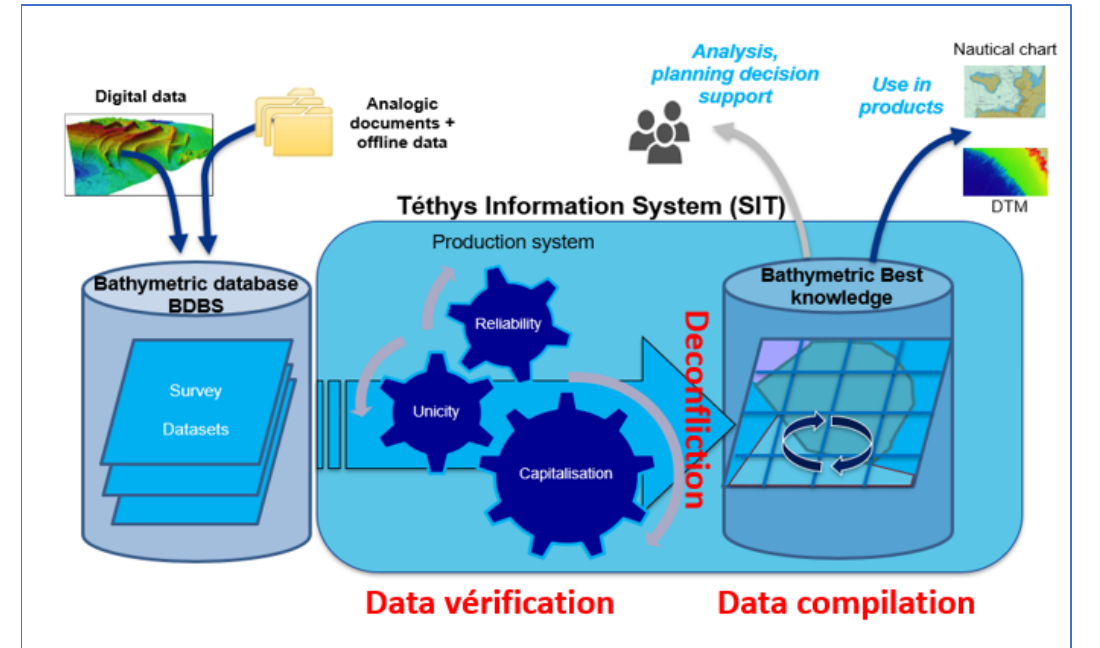
Figure 7. General workflow of Téthys Project, where the Téthys base is the reference bathymetric bottom.